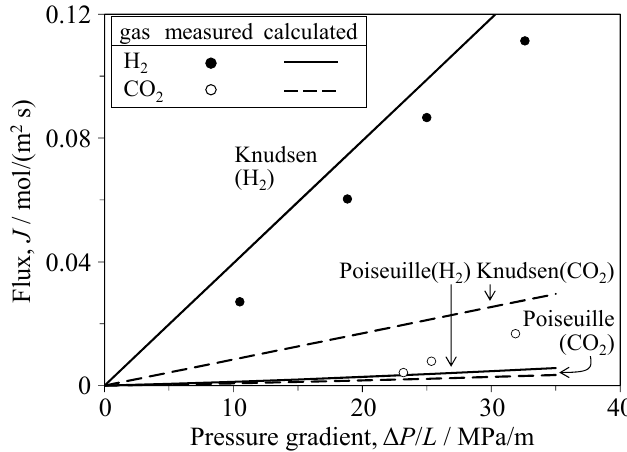
Figure 6. Single-gas flux of H 2 and CO 2 through Al 2 O 3 porous ceramics as a function of the pressure gradient.